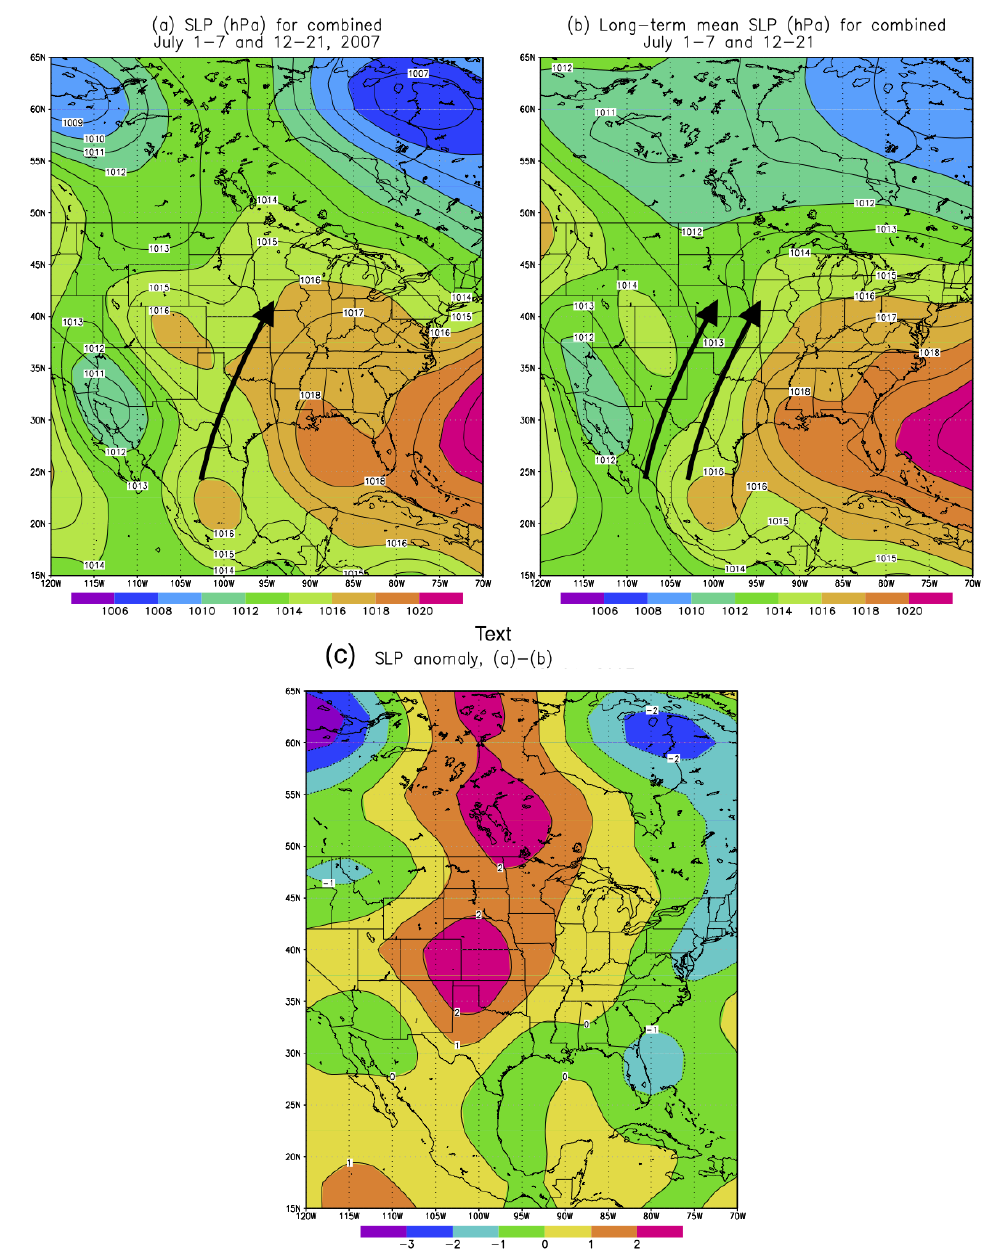
Figure 10. Same as Figure 5, except for the July 2007